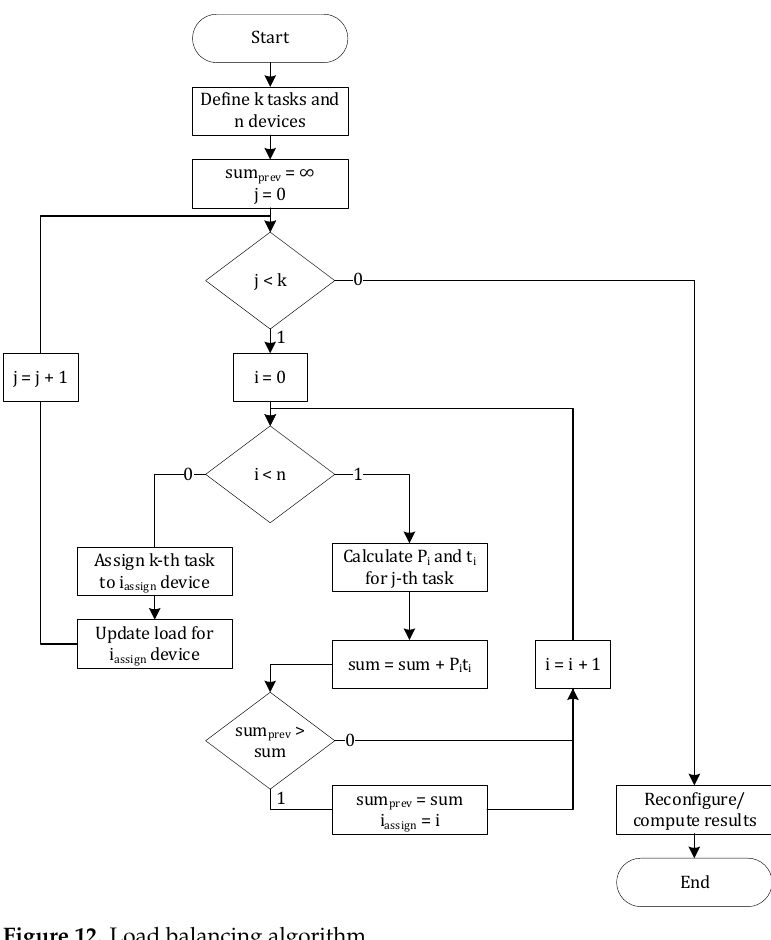
Figure 12. Load balancing